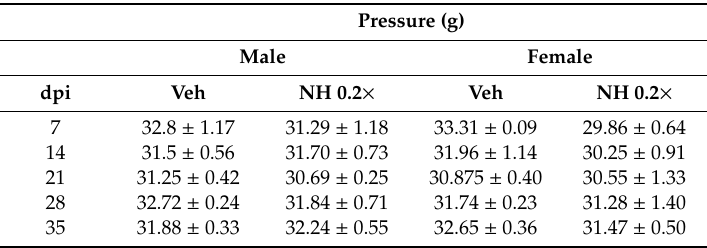
Table 2. Mechanical sensory thresholds (mean ± SEM) recorded at the lateral side of the contralateral hindlimb from males and females treated with Vehicle or NeuroHeal after spared nerve injury at di ff erent dpi.